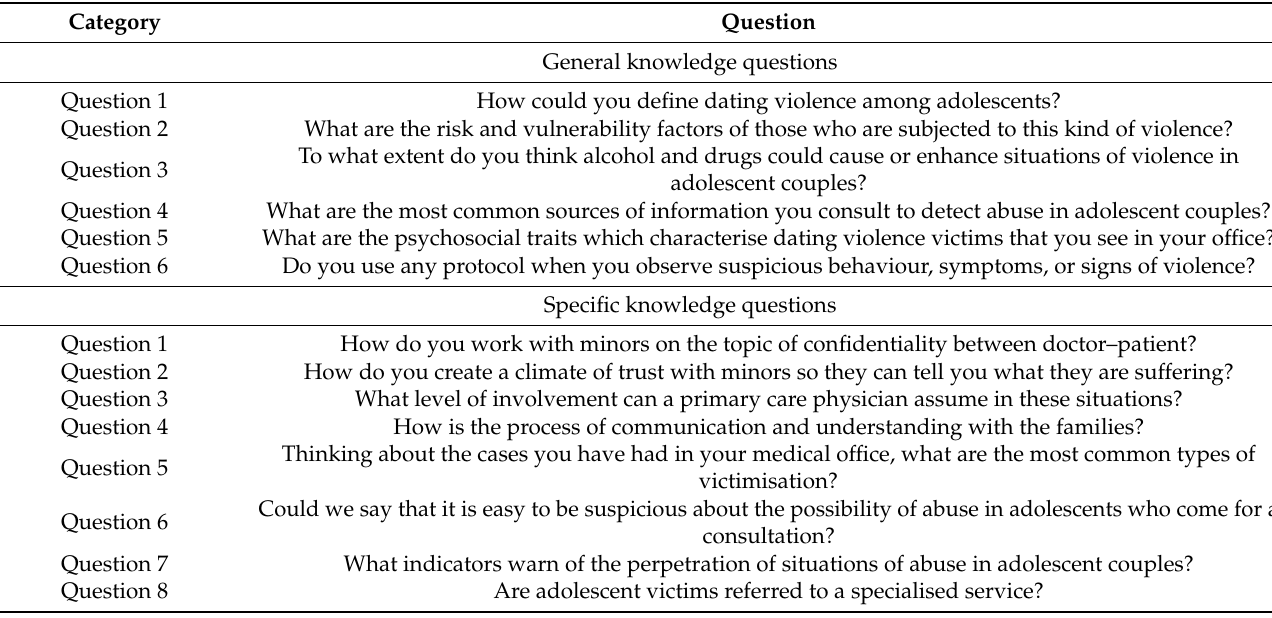
Table 1. Outline of the